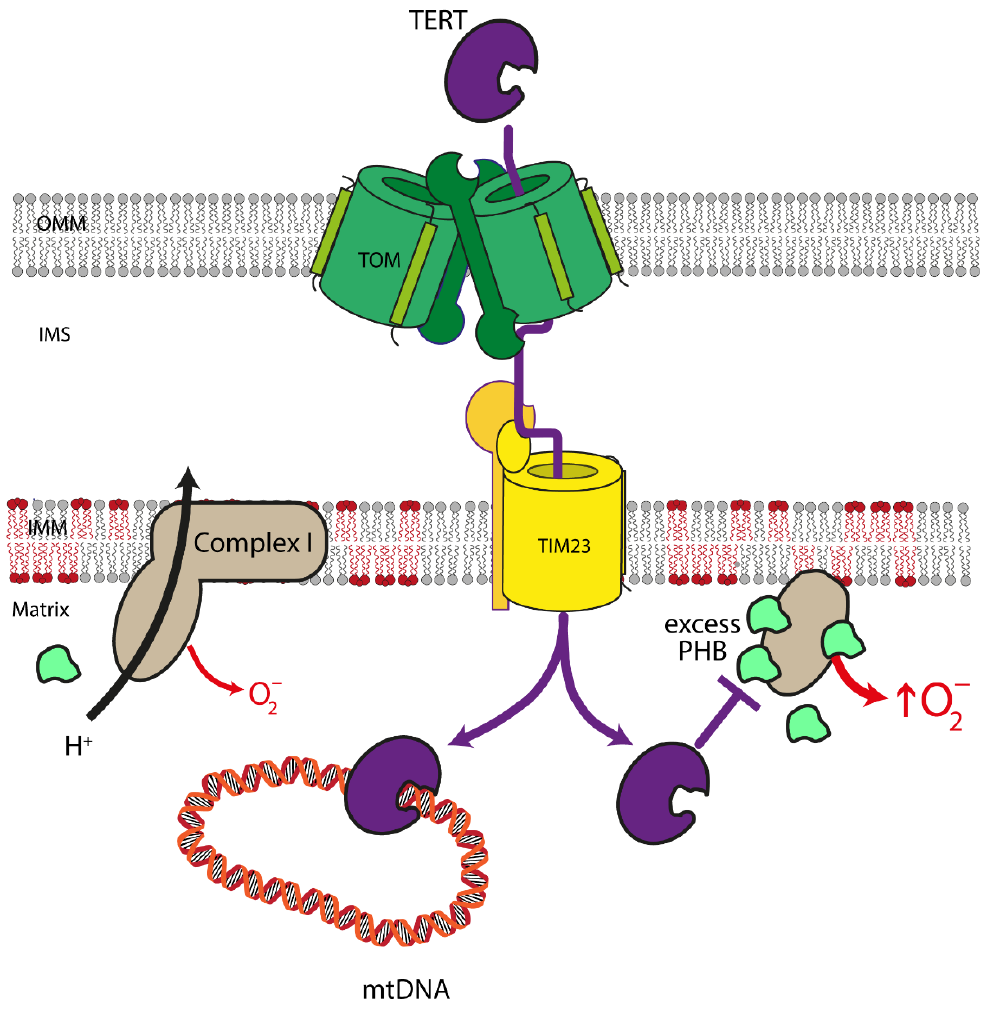
Figure 4. Mitochondrial functions of TERT in the cardiovascular system. In the mitochondria, Telomerase Reverse Transcriptase (TERT) binds to mitochondrial DNA (mtDNA) and protects it against damage. In addition, mitochondrial TERT improves the stoichiometry of the different subunits of complex I of the electron transport chain. Moreover, an increase in mitochondrial TERT reduces the levels of Prohibitin (PHB) in these organelles, which—when in excess—stabilizes free matrix arm subunits of complex I of the electron transport chain resulting in increased production of mitochondrial superoxide. Consequently, mitochondrial TERT improves complex I composition and activity, decreases mitochondrial reactive oxygen levels, and, thereby, contributes to enhanced mitochondrial functionality.